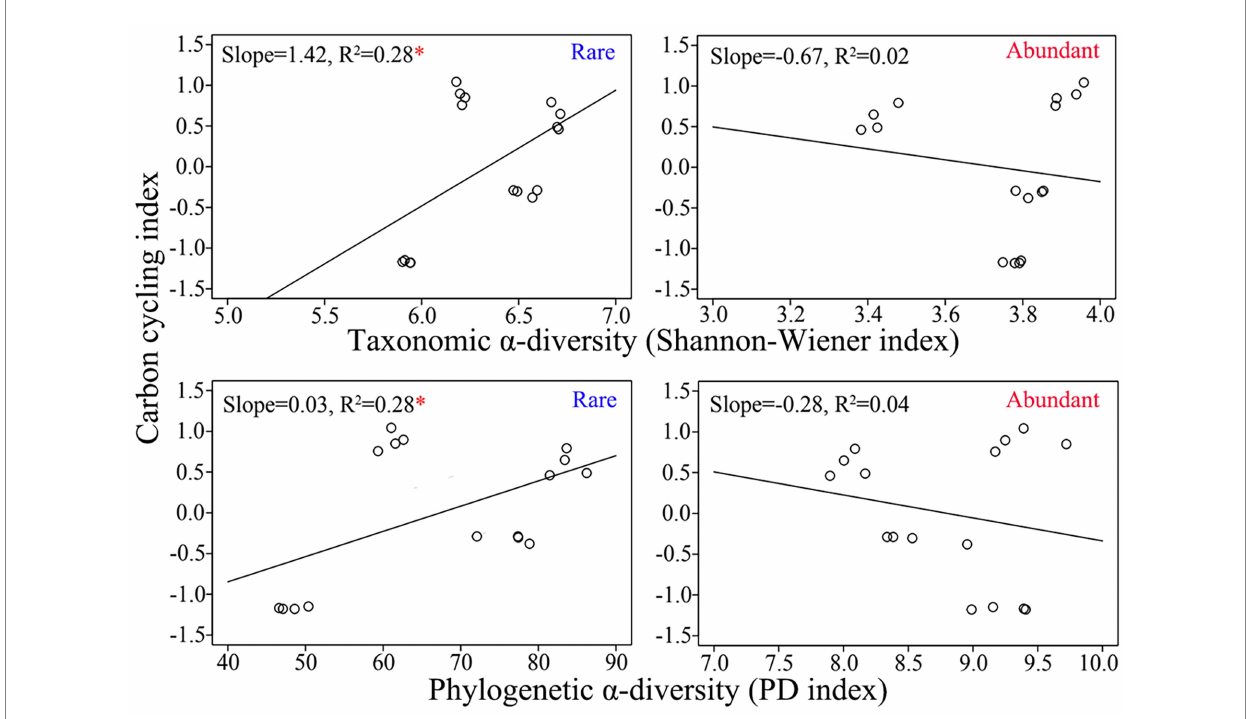
FIGURE 3 Correlations between the carbon cycle index and α -diversity of rare and abundant taxa. The asterisk indicates significance ( * , p < 0.05).